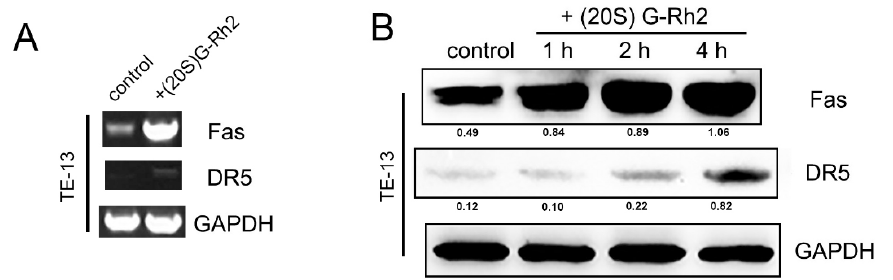
Figure 6. Changes at mRNA and protein levels of the death receptor family members in TE-13 cells after being treated with (20S) G-Rh2. ( A ) RT-PCR results of TE-13 cells after being treated with (20S) G-Rh2; ( B ) protein levels of death receptors Fas and DR5 in TE-13 cells after being treated with (20S) G-Rh2.